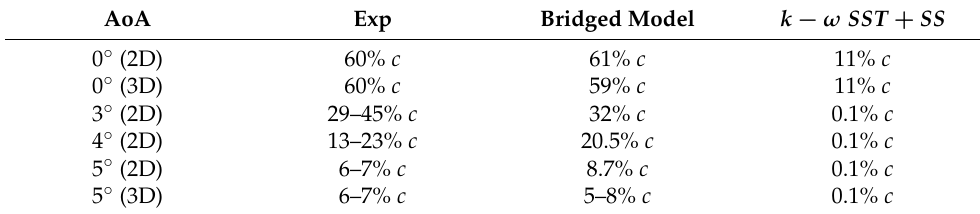
Table 8. Summary of sheet cavitation inception